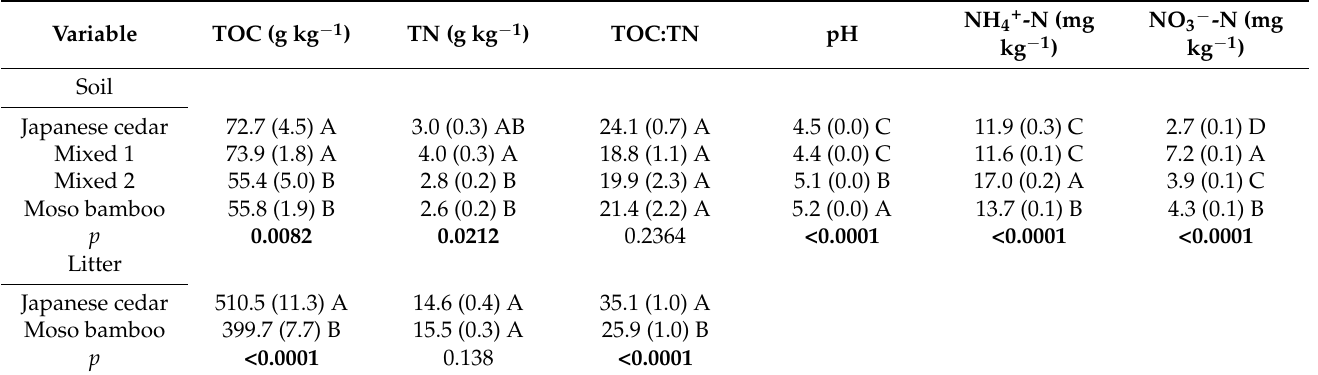
Table 1. Chemical properties (means ± se) of soil (Japanese cedar, mixed 1, mixed 2, and moso bamboo) and litter (Japanese cedar and moso bamboo). p values based on one-way ANOVA are shown. Means with the same letter indicate no significant difference in post hoc tests. Results with significant p values are shown in